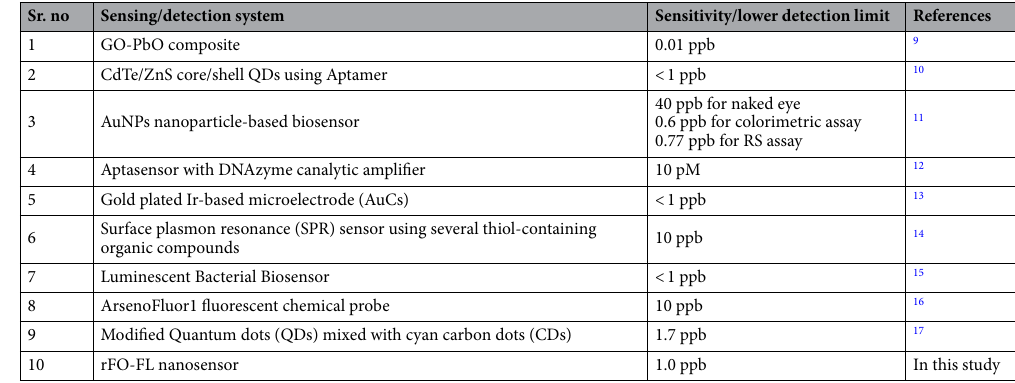
Table 1. Highly sensitive arsenic detection/sensing systems reported in the literature.